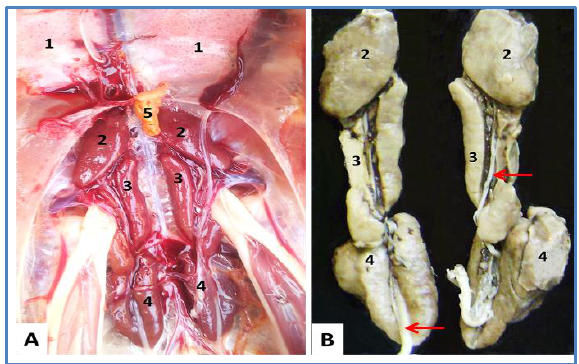
Figure, 1: Micrograph (A): coelomic cavity of Flamingos shows: Lungs (1), kidneys cranial lobes (2), kidneys middle lobes (3) and kidneys caudal lobes (4). Micrograph (B): Left and right kidneys were removed out of coelomic cavity shows: cranial lobes (2), middle lobes (3) caudal lobes (4) and ureter (red arrows).